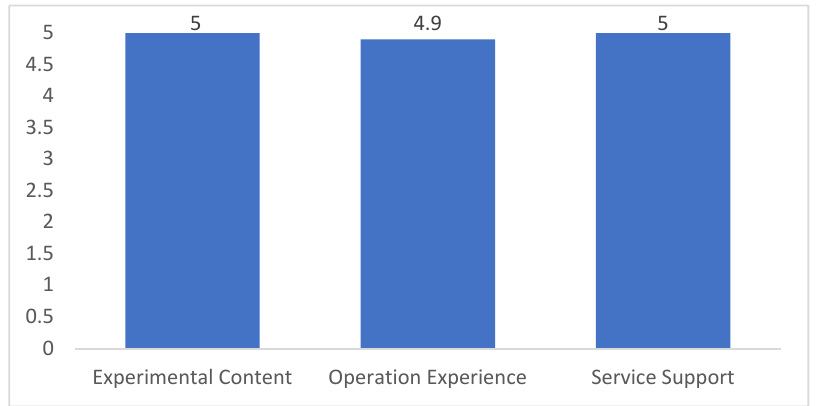
Figure 24. Students grade the system from three aspects.